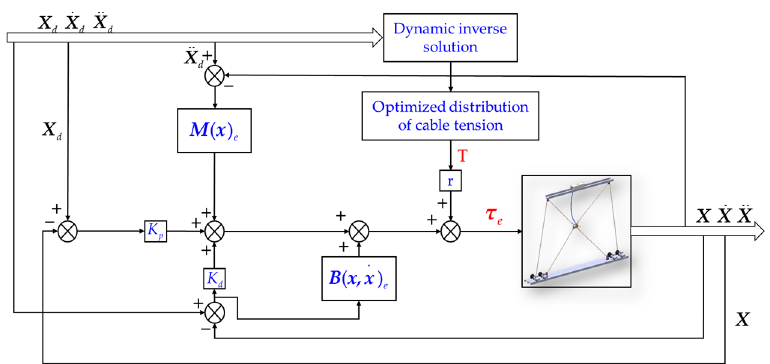
Figure 4. Control strategy of C ‐ DCR.